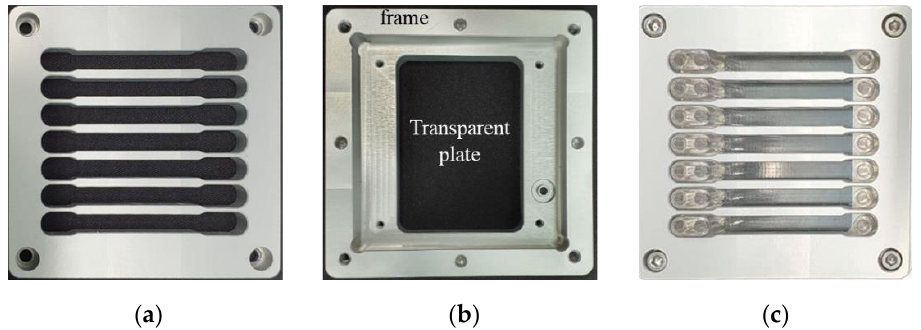
Figure 10. Aluminum holder machined mechanically for micro-channel device: ( a ) upper half of holder, ( b ) lower half of holder, and ( c ) assembly of holder and micro-channel device.